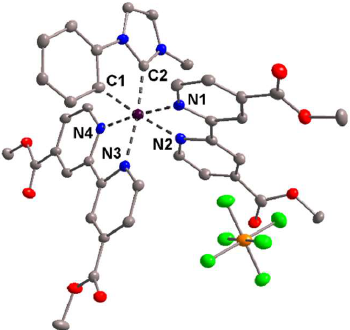
Figure 22 . Structural representation of asymmetrical unit of SA-x (hydrogen atoms are omitted for clarity). Color code: Ru—violet; N—blue; C—gray; O—red; P—orange; F—green. Bond distances: